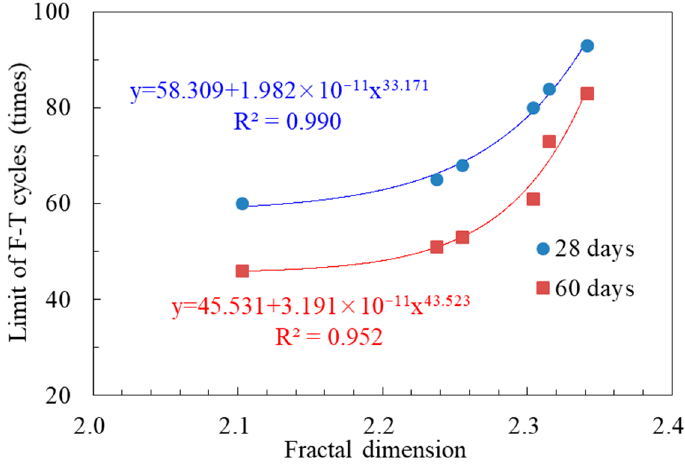
Figure 13. The relationships between surface fractal dimension and limit of F-T cycles.